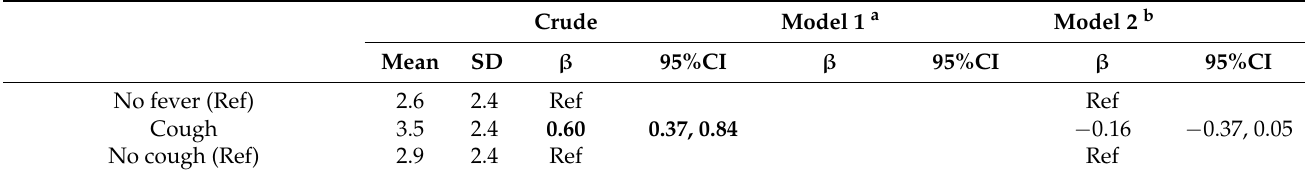
a Model 1 was adjusted for age, sex, employment status, infection waves and vaccination using linear regression model. b Model 2 adjusted for age, sex, employment status, infection waves and vaccination, fatigue, depressive symptom, brain fog, headache, dyspnea, insomnia, palpitation, body pain, loss of smell, loss of appetite, loss of taste, hair loss, fever, and cough using linear regression model. Bold indicates p < 0.05. SD, standard deviation; CI, confidence